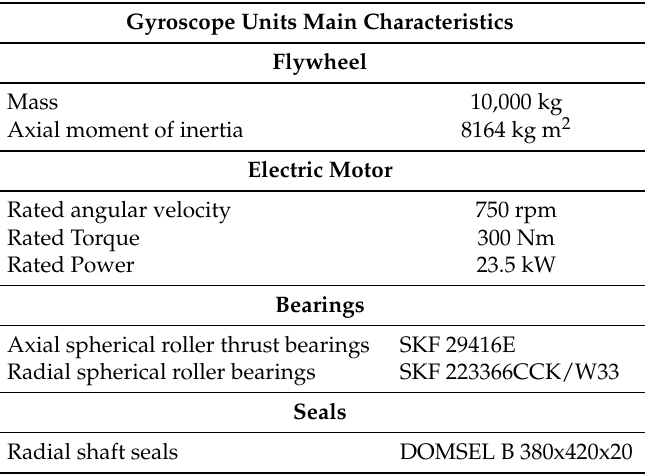
Table 7. Test rig main properties.